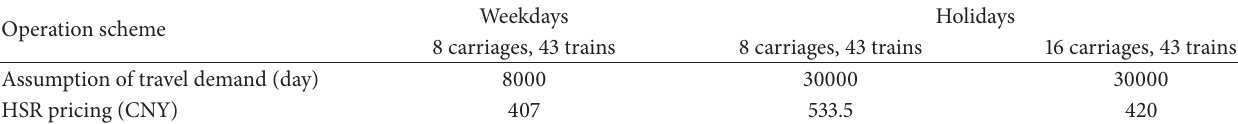
Table 6: Estimations of HSR pricing.